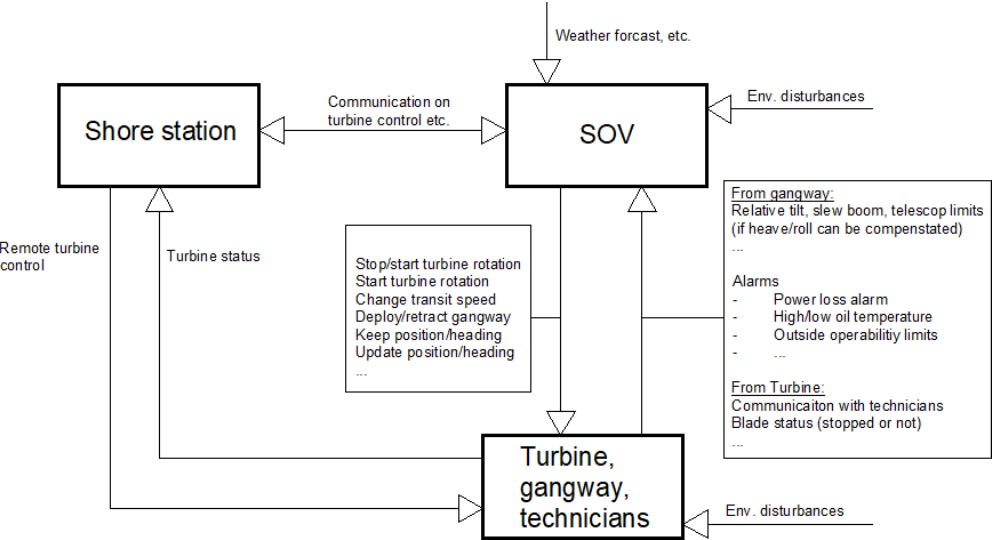
Figure 3. Hierarchical safety control diagram of interface between SOV and turbine (further explained in Sect.